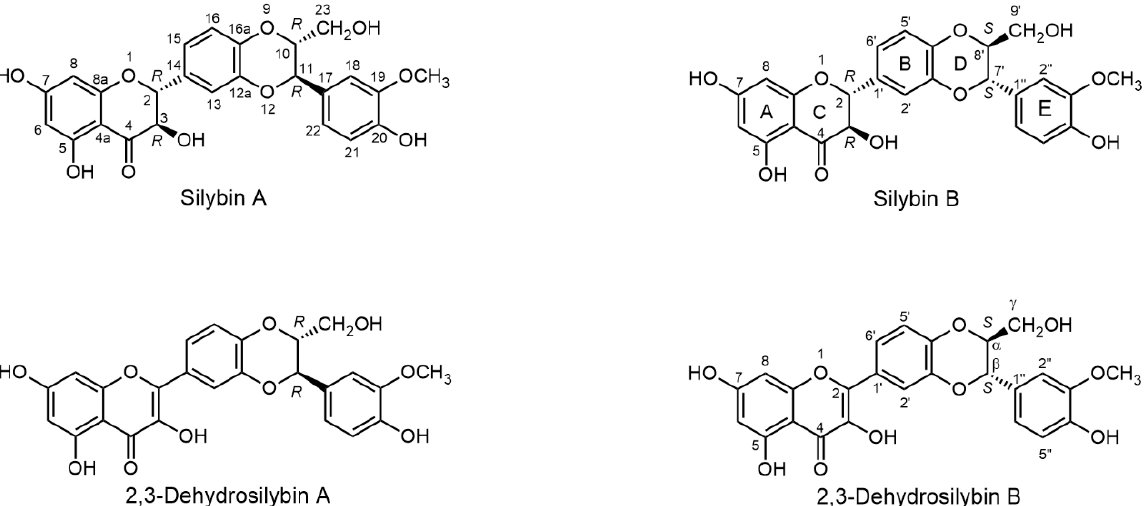
Figure 2. Structures and numbering styles of stereomers of silybin and 2,3-dehydrosilybin: The structure of silybin A is numbered according to a proprietary numbering system used in most chemical papers and also used in this review; the structure of silybin B is numbered according to IUPAC systematic numbering, and for the structure of 2,3-dehydrosilybin B, there is a quasi-systematic numbering used by some groups in the USA [12,21,22]; in some papers, the α - β numbering can be swapped. Other numbering systems used in the older literature for silybin only are detailed in the Supplementary Materials of the paper by Napolitano et al. [23].